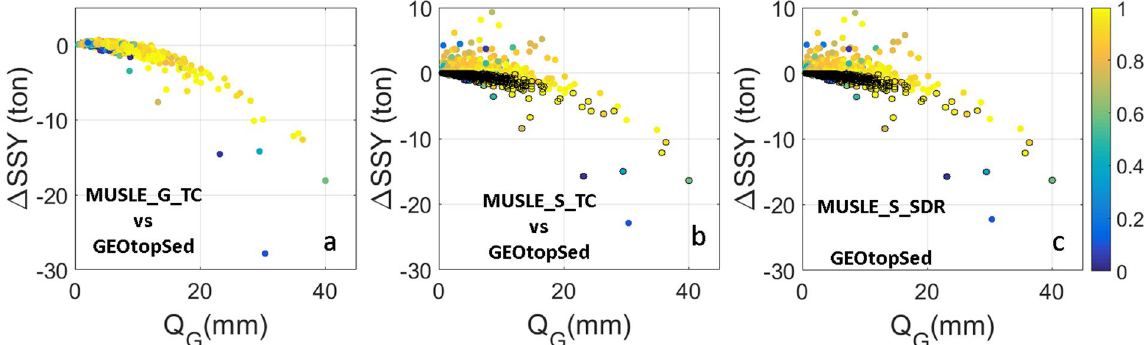
Figure 2. Scatter plots of Δ SSY vs Q G for different MUSLE based model configurations. Δ SSY represents the difference in SSY estimates between different MUSLE based model configurations and GEOtopSed model. Points are color coded with normalized watershed average antecedent soil moisture ( θ ˆ ) in the top 3.5 cm soil layer. Colored dots with black edges indicate underestimation of surface runoff by the MUSLE based model configurations w.r.t. GEOtopSed.